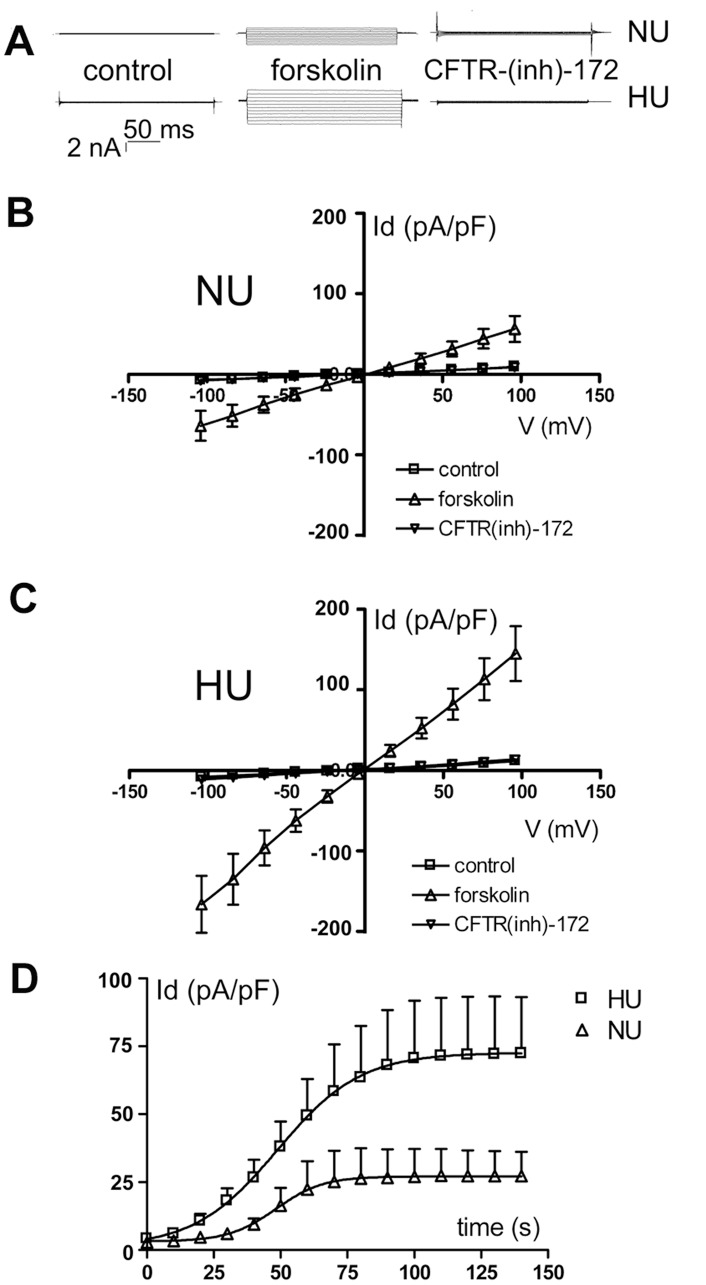
G460W adducin affects CFTR whole-cell current.Chloride currents in NU12 and HU33 cells overepressing the CFTR channel (patch-clamp, whole-cell configuration). A) Representative traces of the currents recorded in NU12 (NU) and HU33 (HU) cells in the presence of symmetrical solutions (control), after the exposure to 10 µmol/L forskolin, and to 2 µmol/L CFTR-(inh)-172+10 µmol/L forskolin. B) Current-density (pA/pF) to voltage (Id-V) relation recorded in NU12 cells (NU) transfected with the pIRES2-EGFP-CFTR vector. Whole-cell currents were recorded in the presence of symmetrical chloride solutions (n = 12), 140 s after forskolin exposure (n = 12), and after CFTR-(inh)-172 inhibition (n = 12). C) Id-V relation recorded in HU33 cells (HU) transfected with the pIRES2-EGFP-CFTR vector (n = 14). The current density was significantly higher after forskolin exposure in HU versus NU cells (P<0.01). D) Activation kinetics of the CFTR-mediated chloride current in NU12 and HU33 cells (NU and HU) transfected with the pIRES2-EGFP-CFTR vector. Activation currents values were interpolated by sigmoid curves, that were significantly different in HU33 versus NU12 cells (P<0.01).